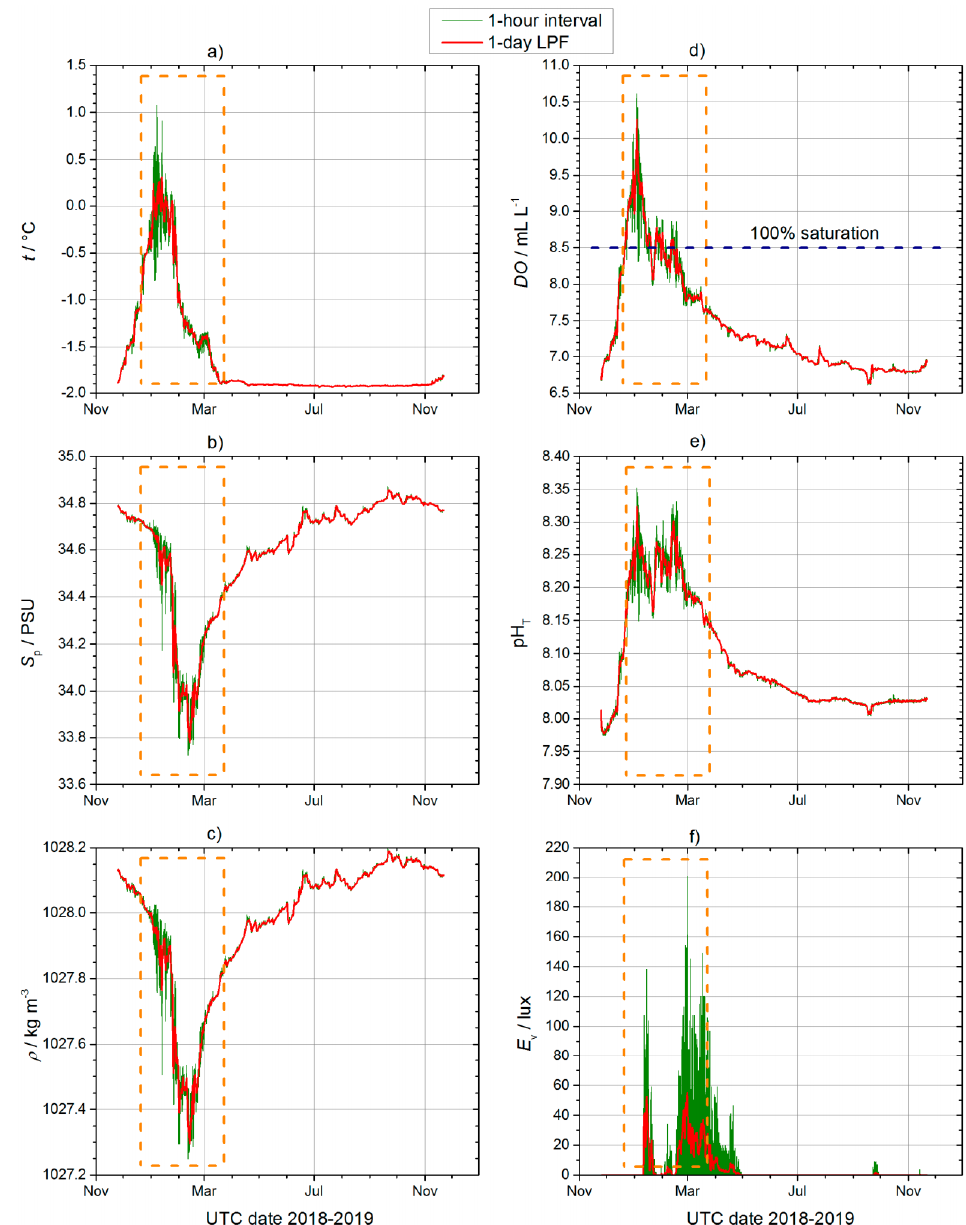
Figure 4. Annual time series of ( a ) temperature t ( ◦ C), ( b ) practical salinity S P (PSU), ( c ) density ρ (kg m − 3 ), ( d ) dissolved oxygen ( DO , mL L − 1 ), ( e ) total scale pH (pH T ), and ( f ) illuminance E V (lux) measured in Terra Nova Bay between November 2018 and November 2019. Frequency of acquisition: 1 date per hour. The adjacent-averaging smoothing filter (low-pass filter (LPF) with a moving window of 24 h) was applied to reduce daily spikes and/or noises. Dashed rectangles outline the austral summer